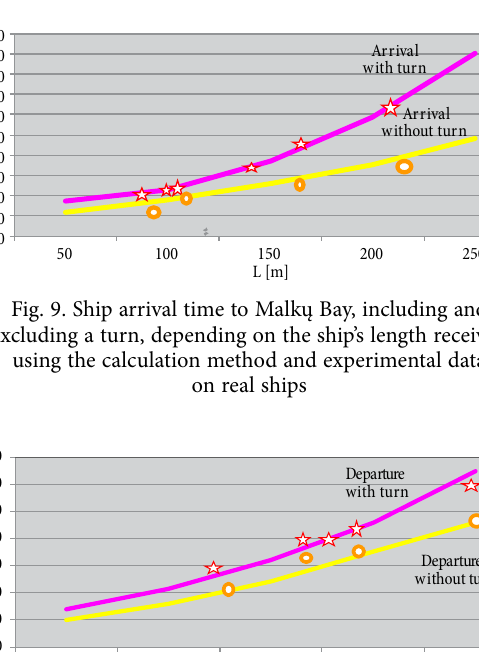
Fig. 7. The entry of a container vessel ( L = 295 m) into Malkų Bay considering the parameters of time, speed, the bollard pull of the tugboat and wind velocity